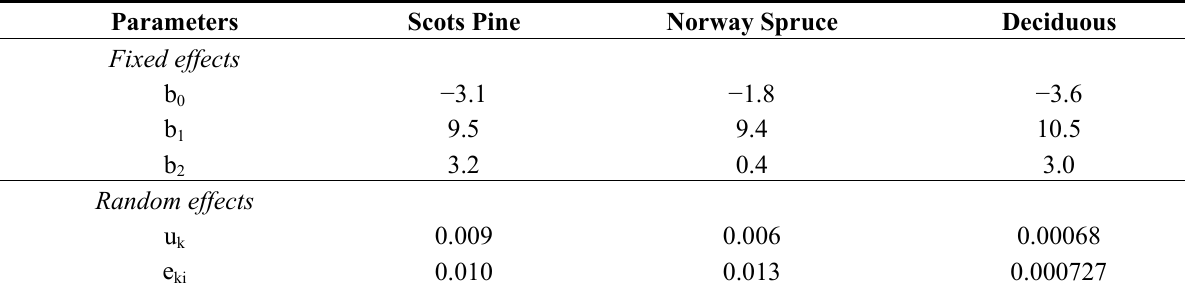
Table 1. Estimates of multivariate model fixed parameters, and variances of random stand ) and residual errors (e ) [31,32]. parameters (u k ki